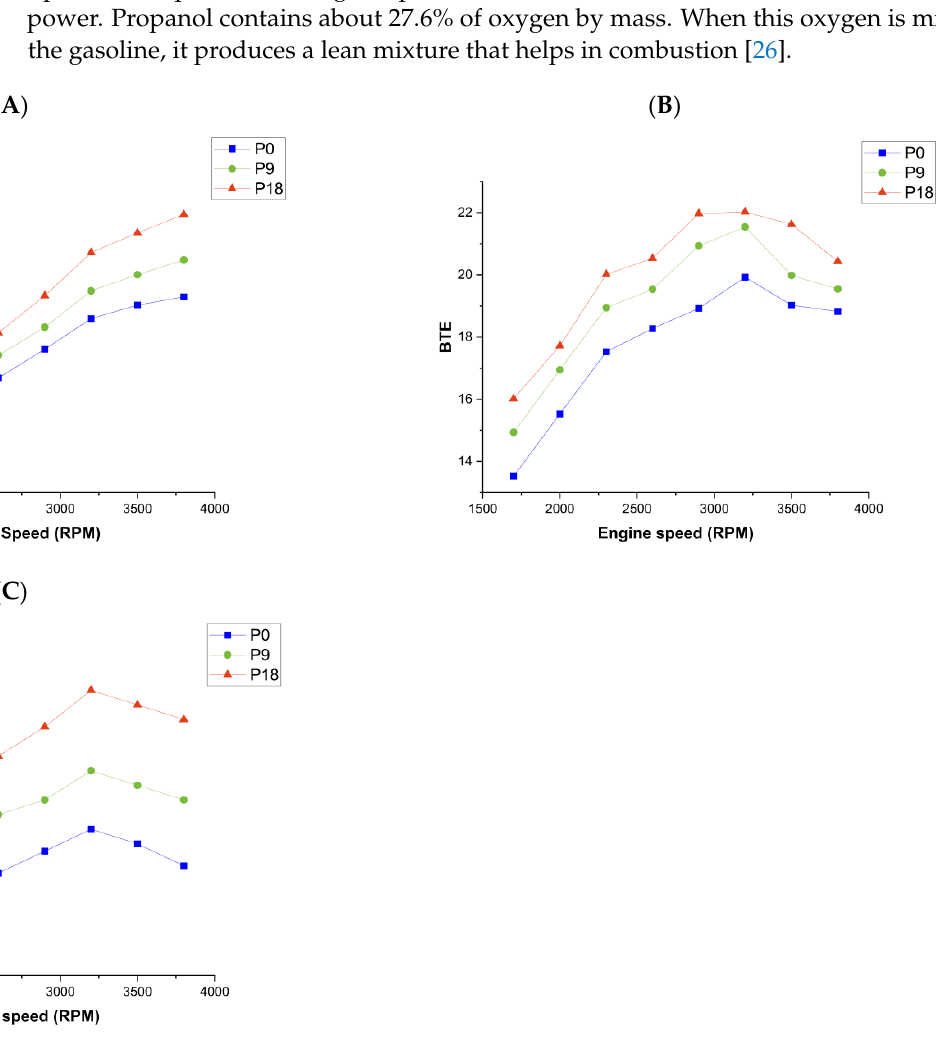
Figure 5. ( A – C ) Changes in Brake power, BTE, and torque for test